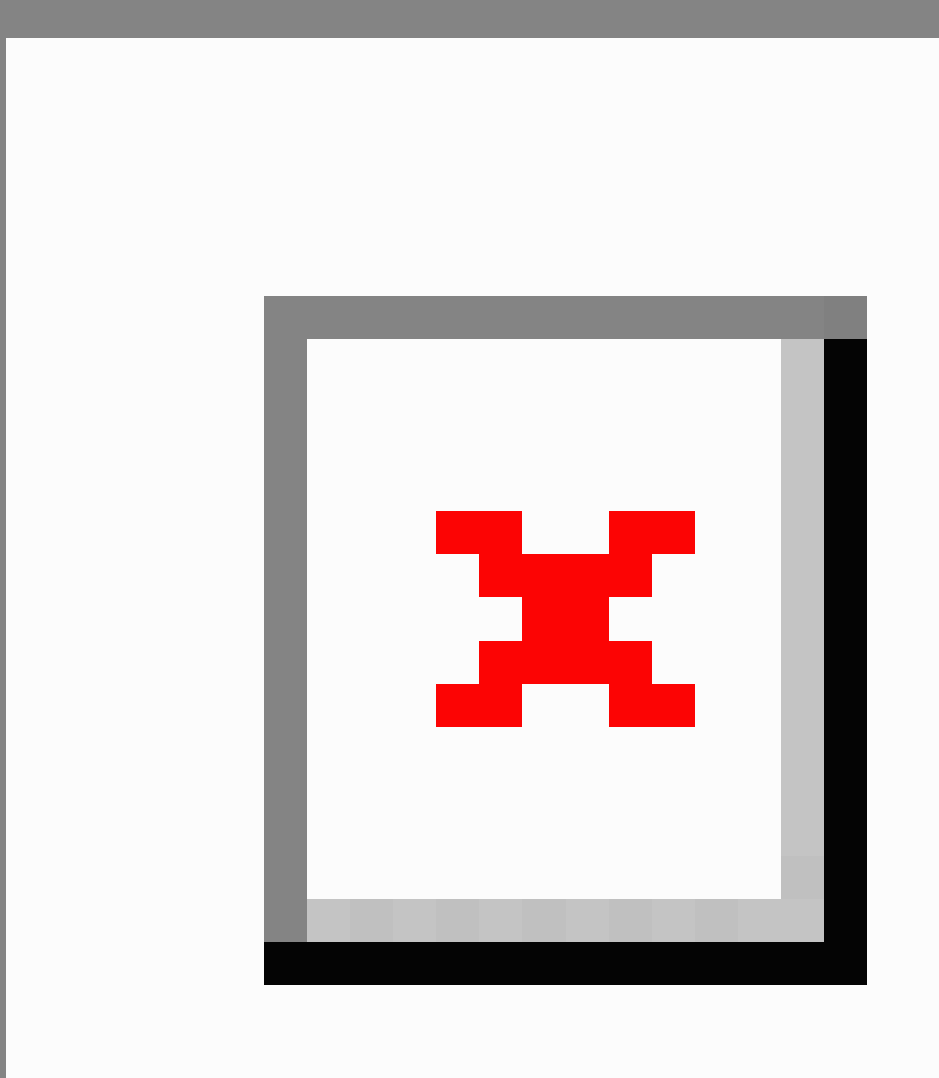
Figure 2. Folder, subject categorization, and preferences features in Secure